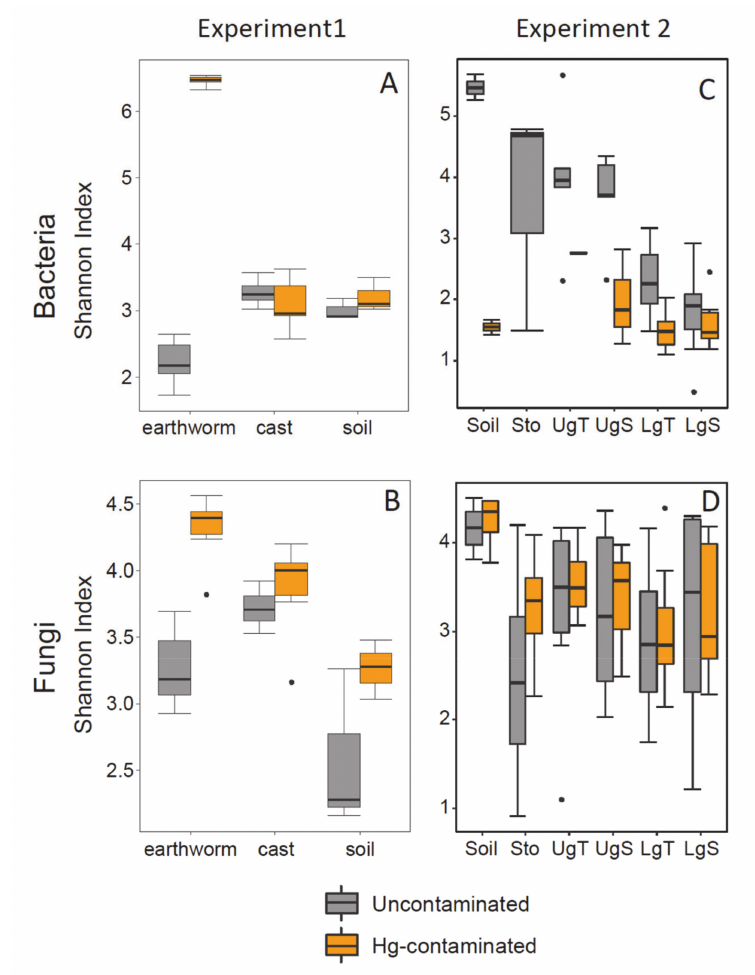
Figure 2. Shannon diversity index for the bacterial ( A ) and fungal ( B ) communities in experiment 1 and for the bacterial ( C ) and fungal ( D ) communities in experiment 2. Sto = stomach, UgT = upper gut tissue, UgS = upper gut soil, LgT = lower gut tissue, LgS = lower gut